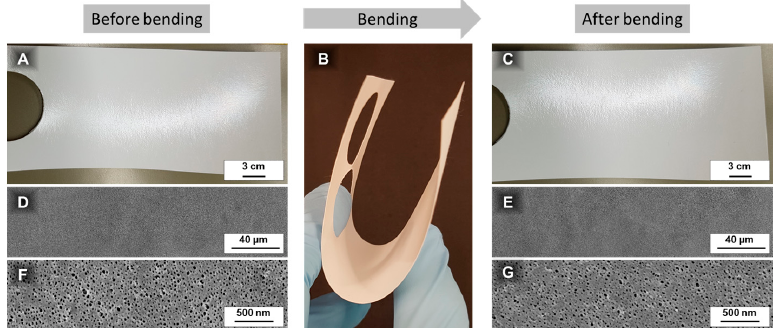
Figure A4. The physical strength of a roller coated PS 83 - b -P4VP 17 _DOX 1001 _15s membrane was tested by bending a sample and comparing the surface before ( A, D, F ) and after ( C, E, G ) this test. Photographic image ( C ) and SEM-images ( E, G ) do not show any destruction of the sample after bending and remain unchanged.